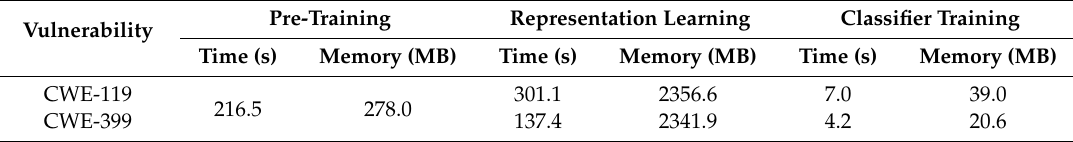
Table 7. The complexity of our method on di ff erent types of vulnerability.